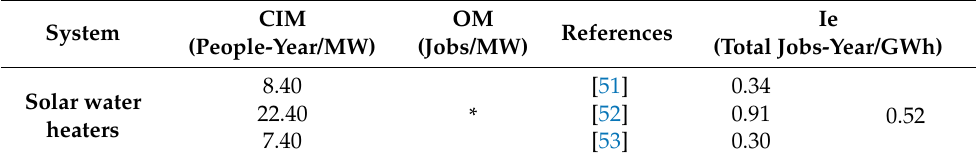
Table 25. Employment indicator (DHW production).